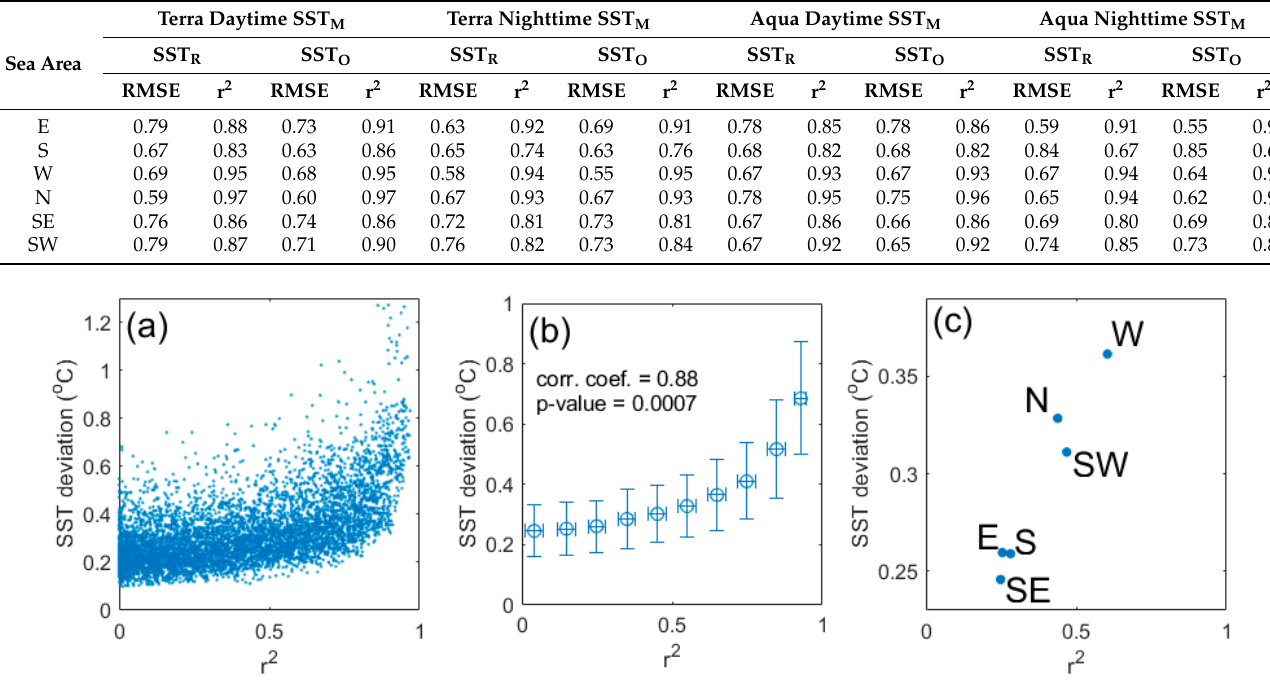
Figure 9. ( a ) Scatter plot of r 2 and SST O deviation. ( b ) Scatter plot of r 2 and averaged SST O deviation per 0.1 interval of r 2 , bars are error bars of one standard deviation. ( c ) Scatter plot of r 2 and SST O deviation for the six areas.